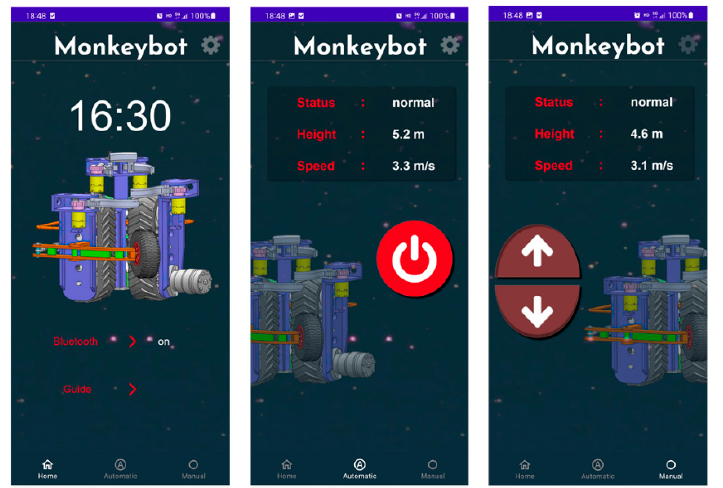
Figure 11. APP for Figure 11. APP for smartphones.